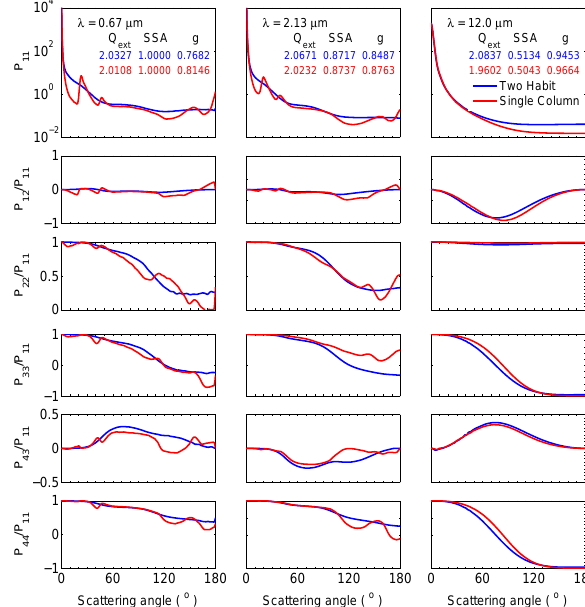
Figure 8. Comparison of bulk non-zero phase matrix elements of the two-habit model and the single-column model with an effective diameter of 30µm at wavelengths 0.67, 2.13 and